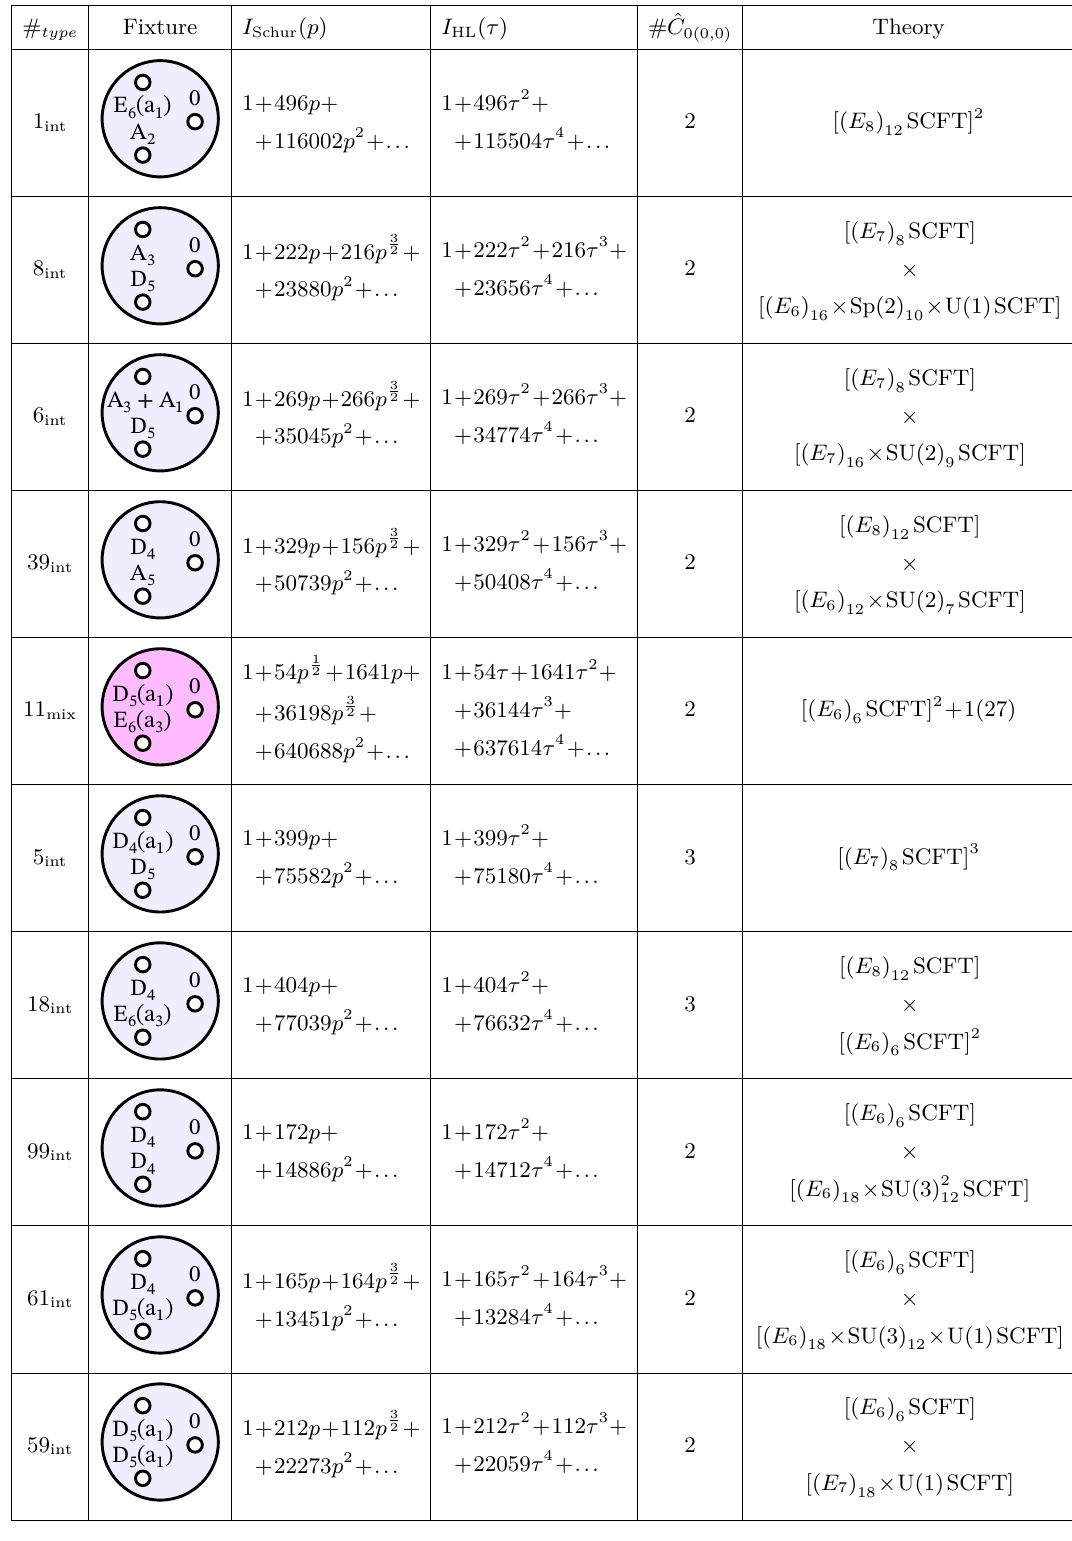
Table 2. Product theories corresponding to fixtures in the untwisted E 6